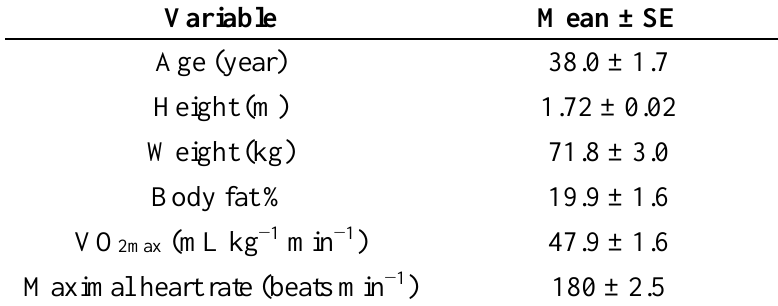
Table 1. Subject characteristics ( n = 24 total, with n = 16 males, n = 8 females)